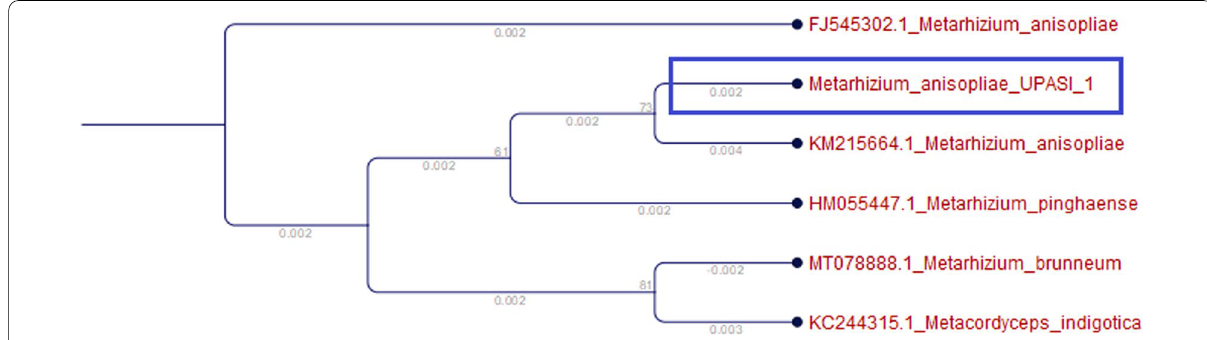
Fig. 1 Phylogenic tree of Metarhizium anisopliae isolate UPASI_1